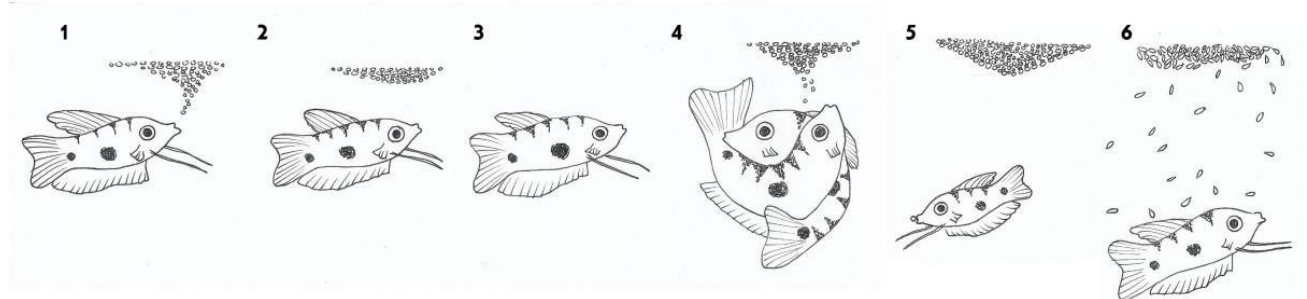
Figure 3. Sexual behavior of male blue gourami during the reproductive cycle. (1) The male builds a nest. (2) and (3) The male courts the female under the nest. (4) Fertilization takes place and the fertilized eggs float up and stick to the bubble nest. (5) The male guards the eggs in the nest. (6) The male further protects the fry immediately after hatching while they swim in the nest area [10,13].